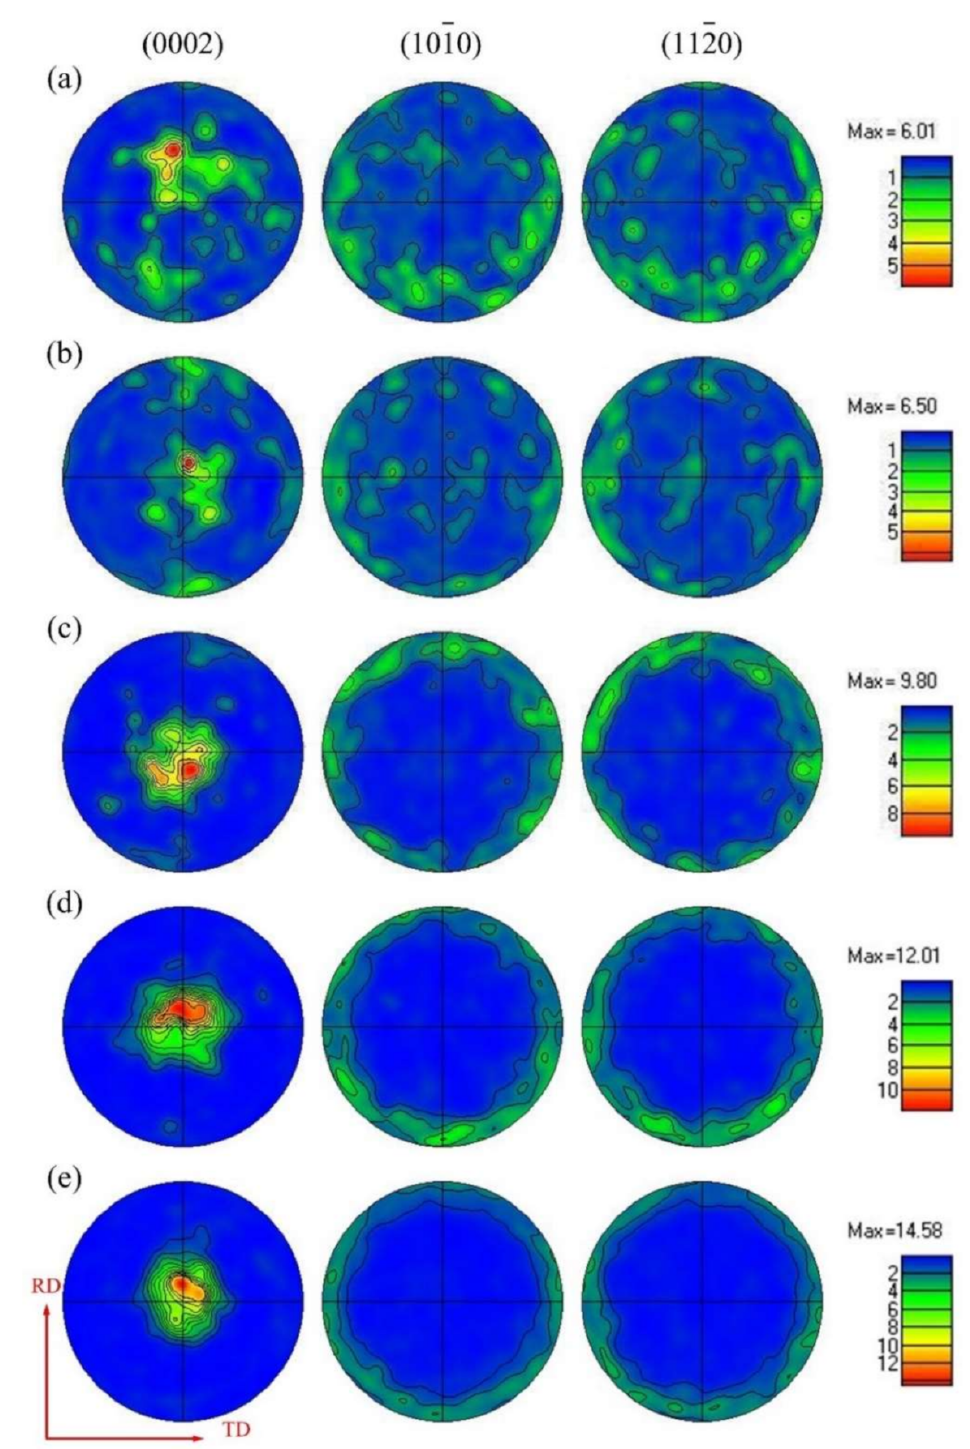
Figure 6. (0002), (10–10), and (11–20) pole figures of AZ31 magnesium alloy sheets during multi-pass lowered-temperature rolling: ( a ) Pass 1; ( b ) Pass 2; ( c ) Pass 4; ( d ) Pass 6; ( e ) Pass 8. (RD: rolling direction, TD: transverse